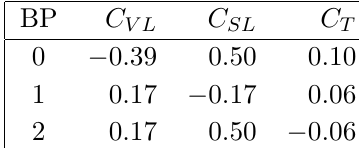
Figure 3 . The clustered three-dimensional parameter space resulting from dBR( B ! D 0 (cid:3) (cid:28)(cid:23) ) = d(cos( (cid:18) V )) distributions is shown. The parameter space is spanned by the three Wil- son coe(cid:14)cients C V L ; C SL and C T , varied within their respective ranges. Three di(cid:11)erent clusters are found in our approach, which are indicated with di(cid:11)erent markers and colours. BPs are given in boldface.